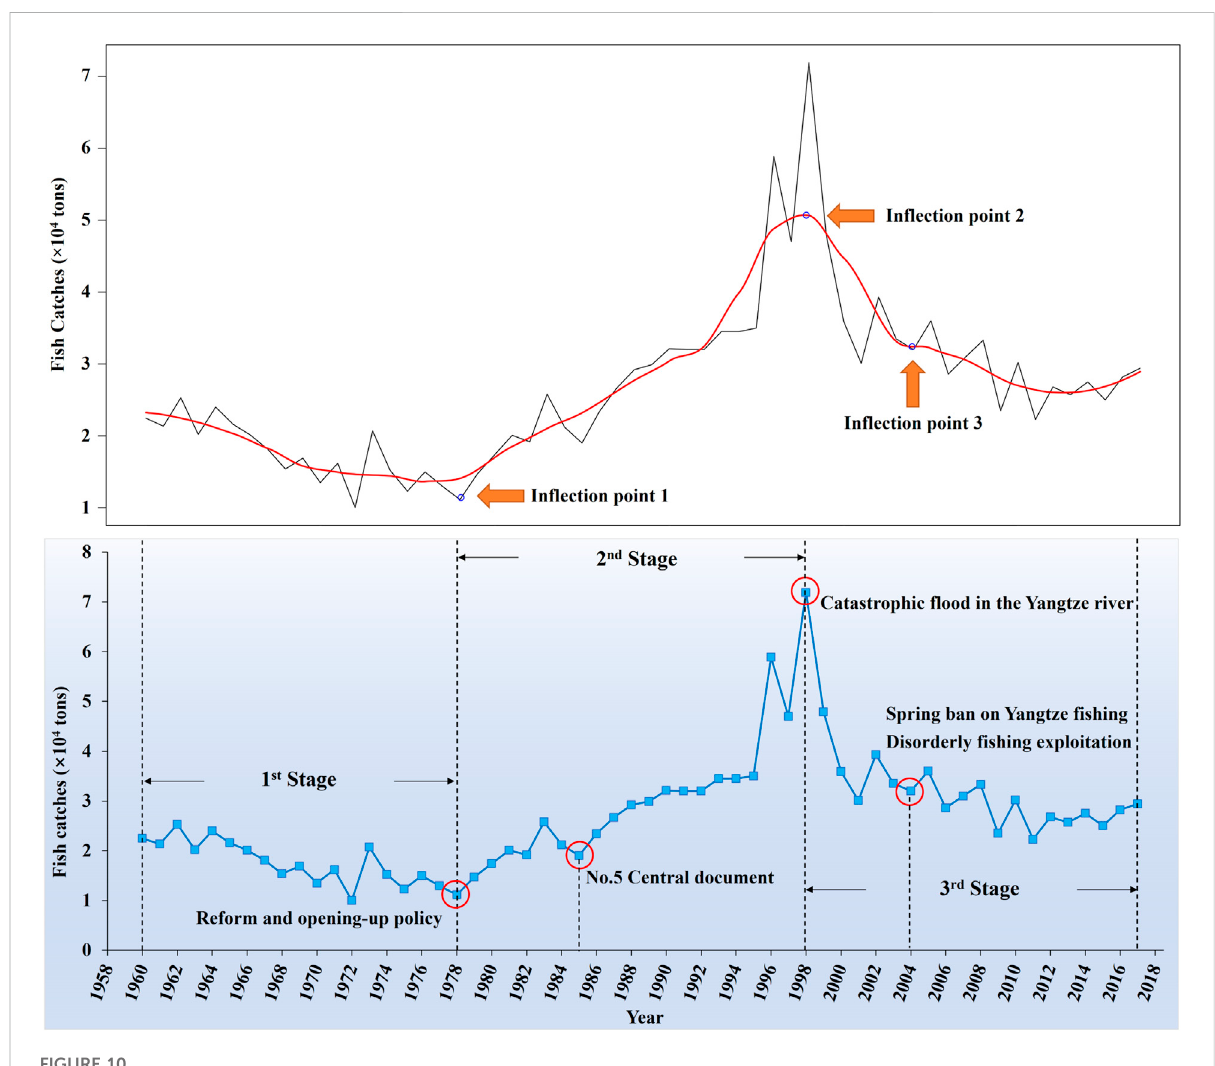
FIGURE 10 Time series of fi sh catches in Poyang Lake and historical background of in fl ection